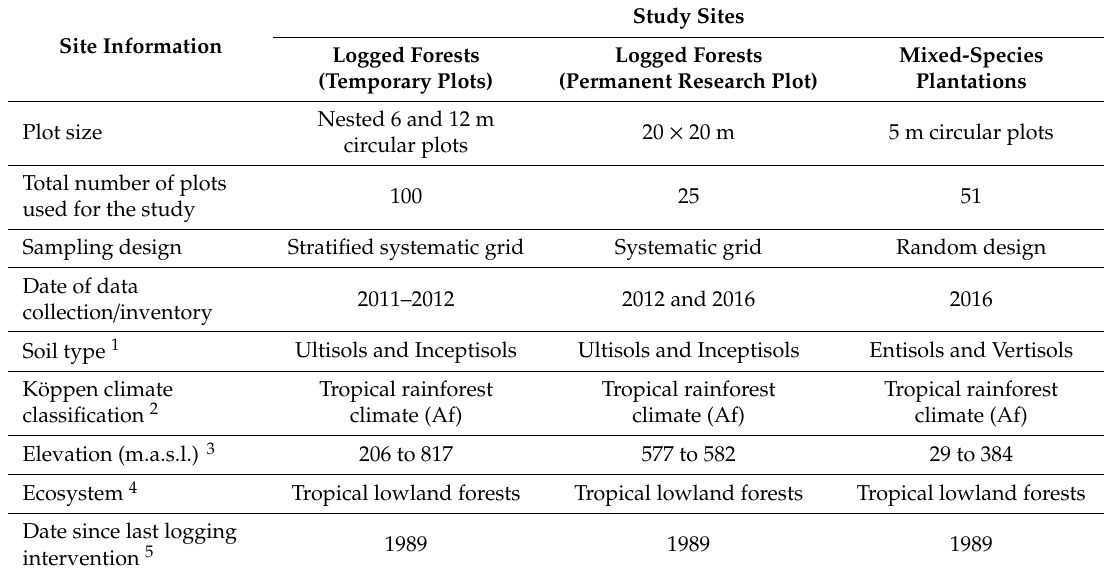
Table 1. Summary information of the three study sites used in the